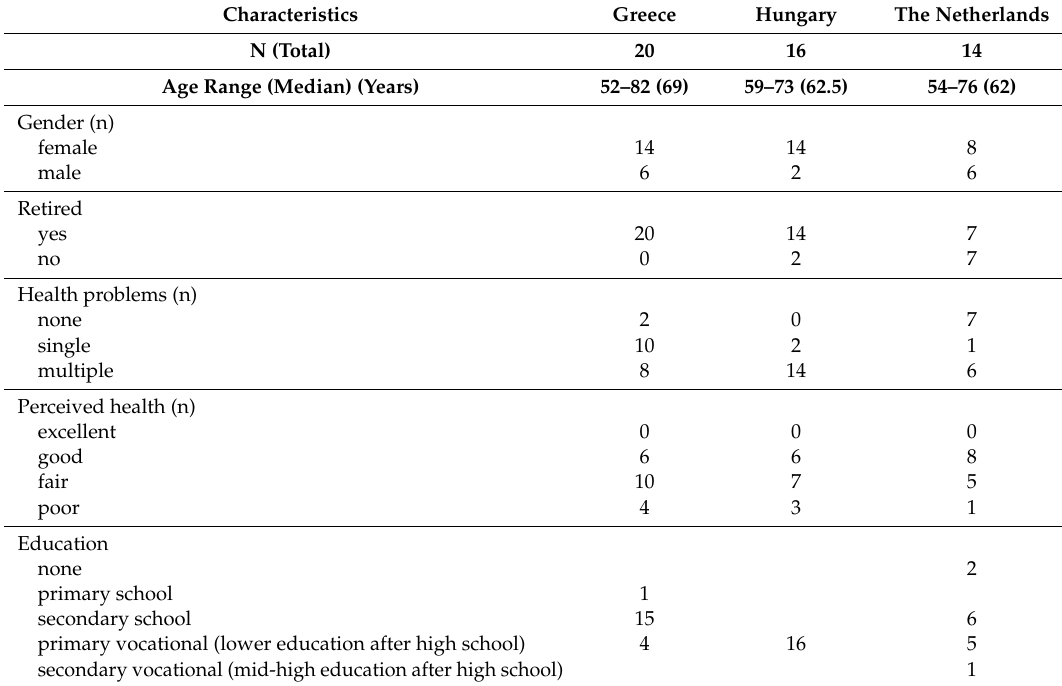
Table 3. Characteristics of the participating older adults.